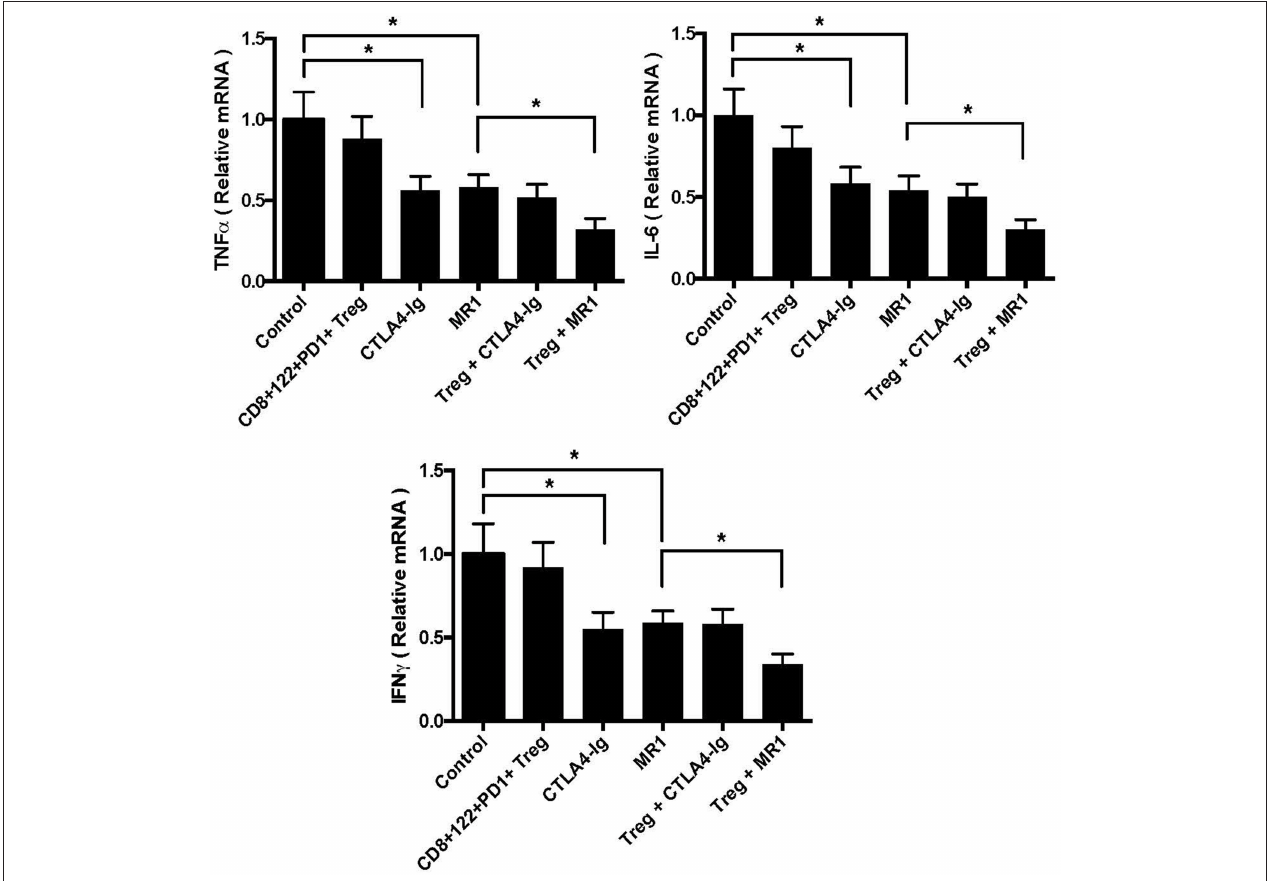
FIGURE 3 | CD8 + CD122 + PD-1 + Tregs synergizes with costimulatory blockade of CD40/CD154, but not B7/CD28, to suppress mRNA expression of proinflammatory cytokines in skin allografts. mRNA expression of IFN- γ , TNF- α , and IL-6 in skin allografts was measured using RT-PCR assays 2 weeks after skin transplantation and treatment with CD8 + CD122 + PD-1 + Tregs, MR1, or CTLA4-Ig. Data are presented as mean ± SD. One representative of three separate experiments is shown (* P <